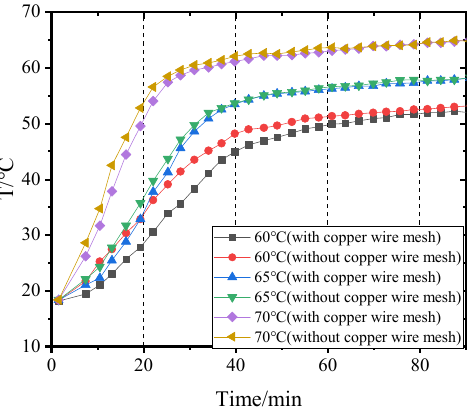
Figure 12. Variation of air temperature at the dehumidifier outlet with time when using PCM-1.